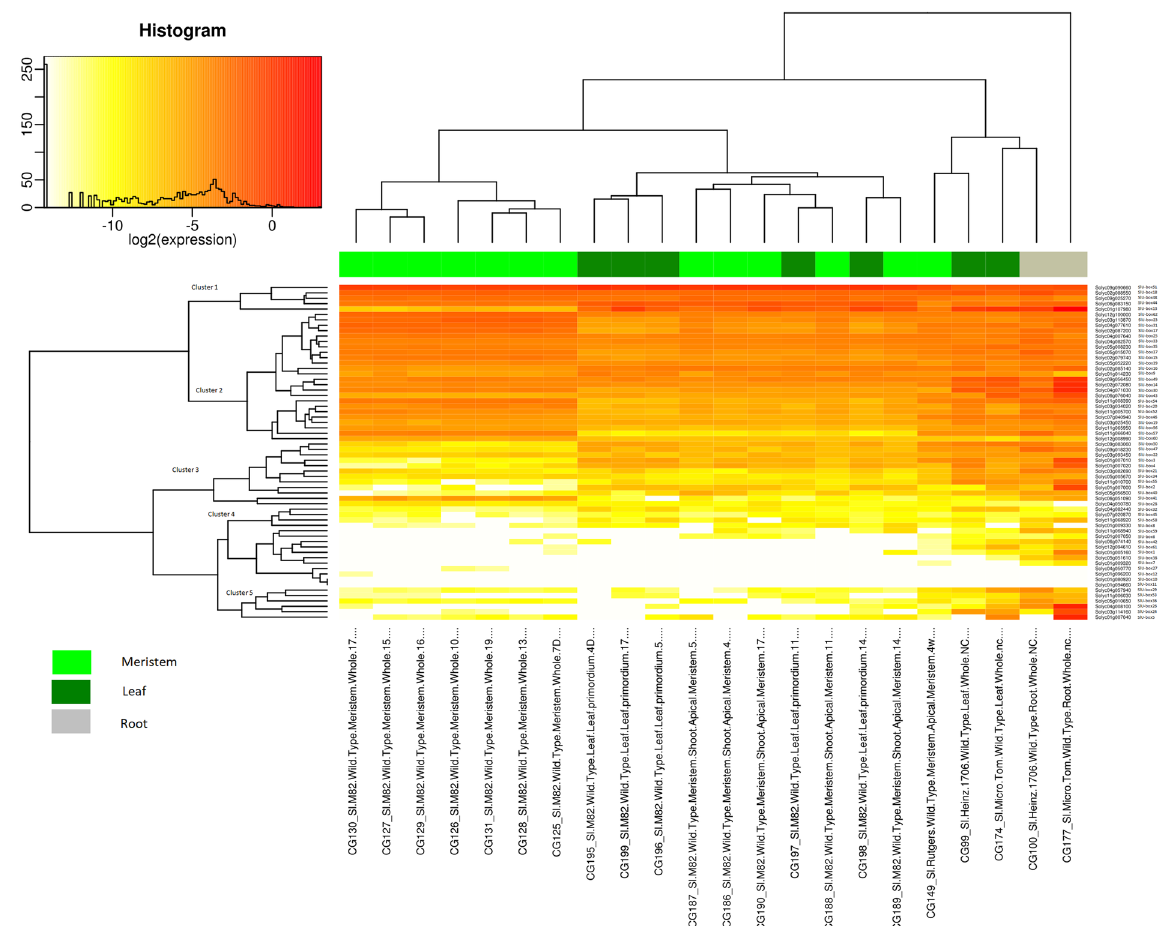
Figure 4. The gene expression level of the 62 U-box gene family members in vegetative tissues (leaf, meristem, root, and apical meristem) was represented by a heat map. (For detailed conditions refer Supplementary Table